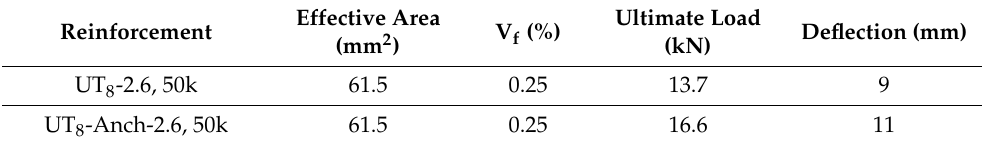
Table 8. Results of anchored and straight end TRC beams.